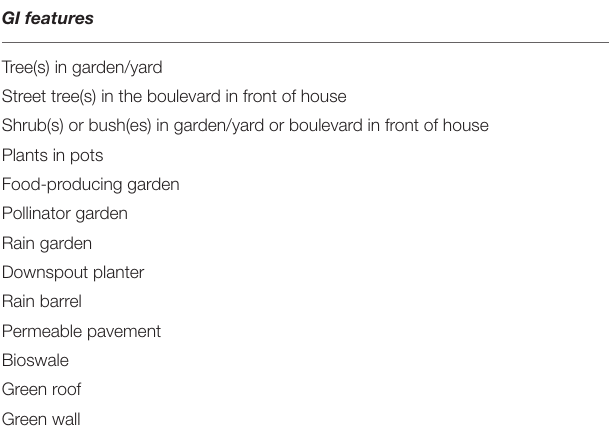
TABLE 1 | Green infrastructure features used in our